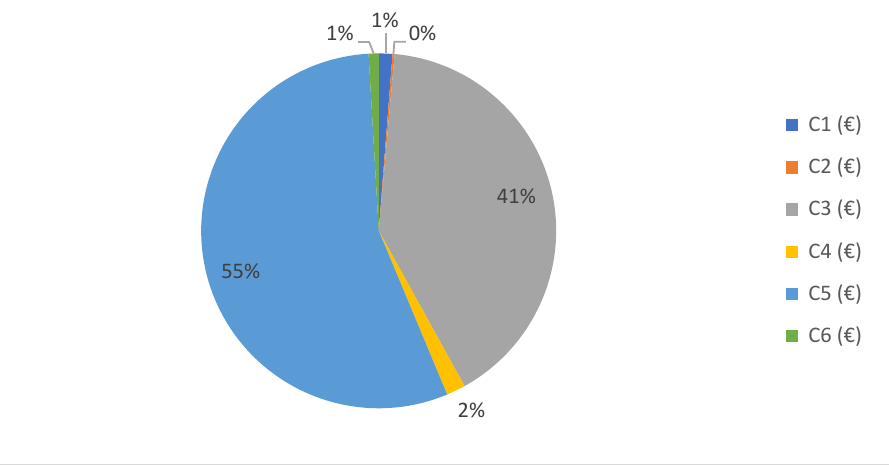
Figure 3. Total cost results. Being C1 (conception and definition cost), C2 (design and development cost), C3 (manufacturing cost), C4 (installation cost), C5 (exploitation cost) and C6 (dismantling cost).